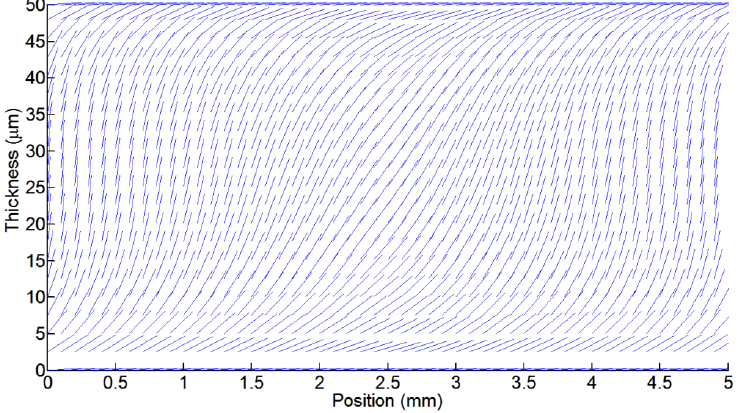
Figure 7. Phase shift profile in the XZ plane, for ( a ) lensacons and ( b ) logarithmic